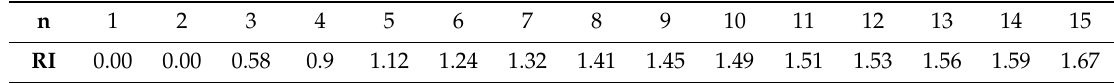
Table 3. Values of random index